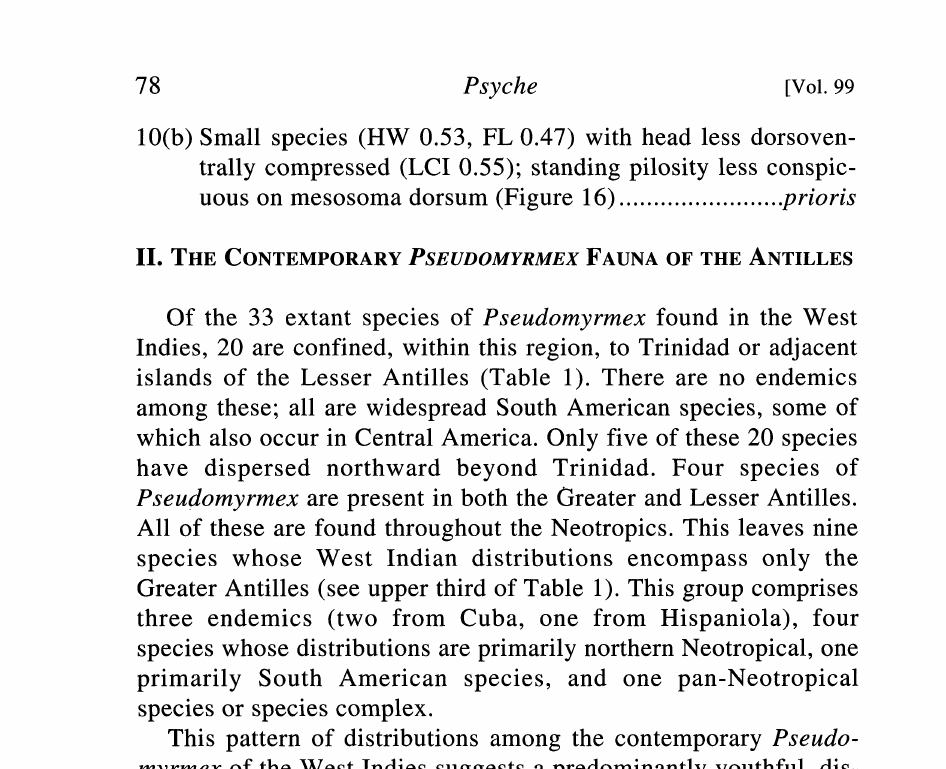
Psyche 10(b) Small species (HW 0.53, FL 0.47) with head less dorsoven- trally compressed (LCI 0.55); standing pilosity less conspic- uous on mesosoma dorsum (Figure 16)